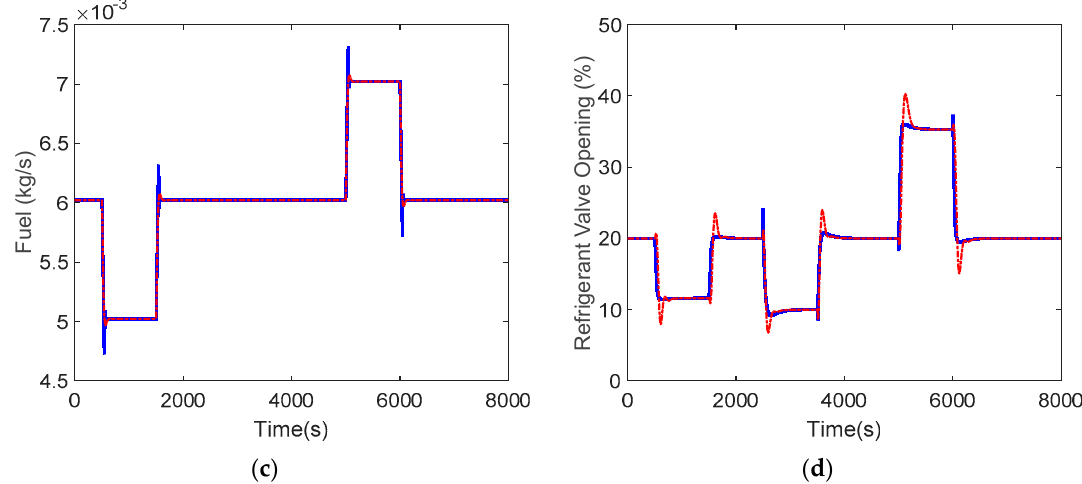
Figure 14. Case 2: performance of unknown input disturbance rejection (Solid in blue: proposed method; dot-dashed in red: PID; dot in green: reference). ( a ) and ( b ) Output variables; ( c ) and ( d ) Manipulated variables.